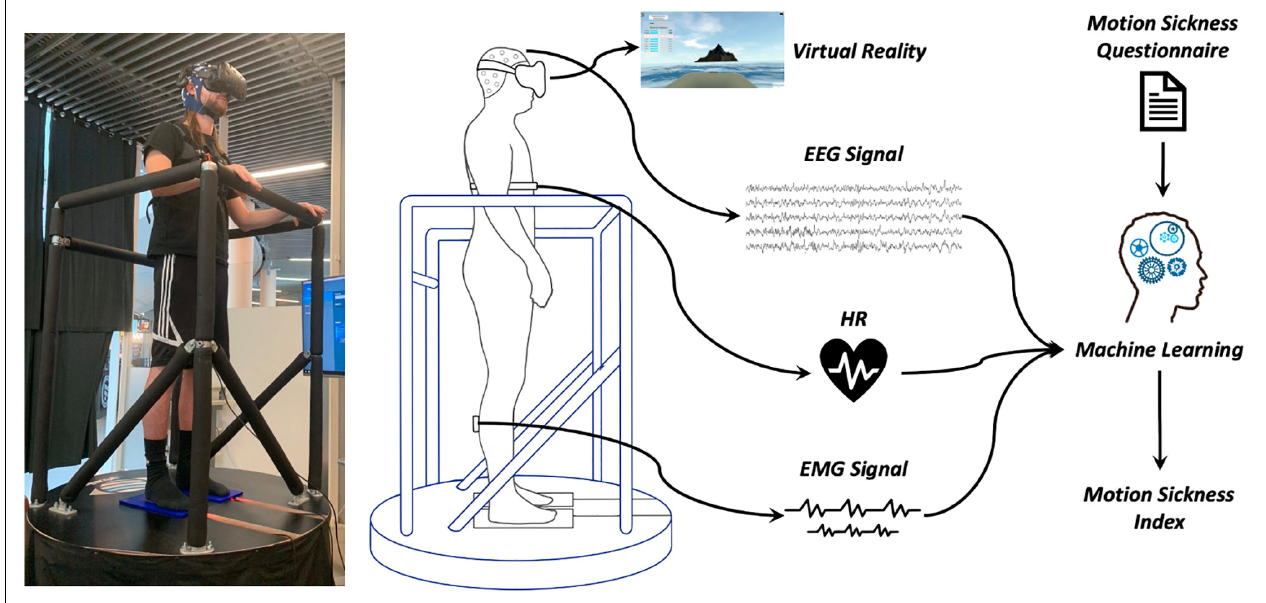
FIGURE 1 | BioVRSea structure: the moving platform, shown in a photo with a subject on the left, is combined with a rough sea VR scenario and with EEG, EMG, and HR bio-signal acquisition.